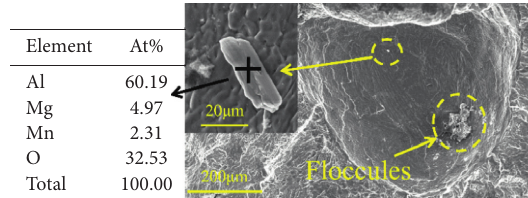
Figure 11: Metallurgical pore with second phase and flocs.